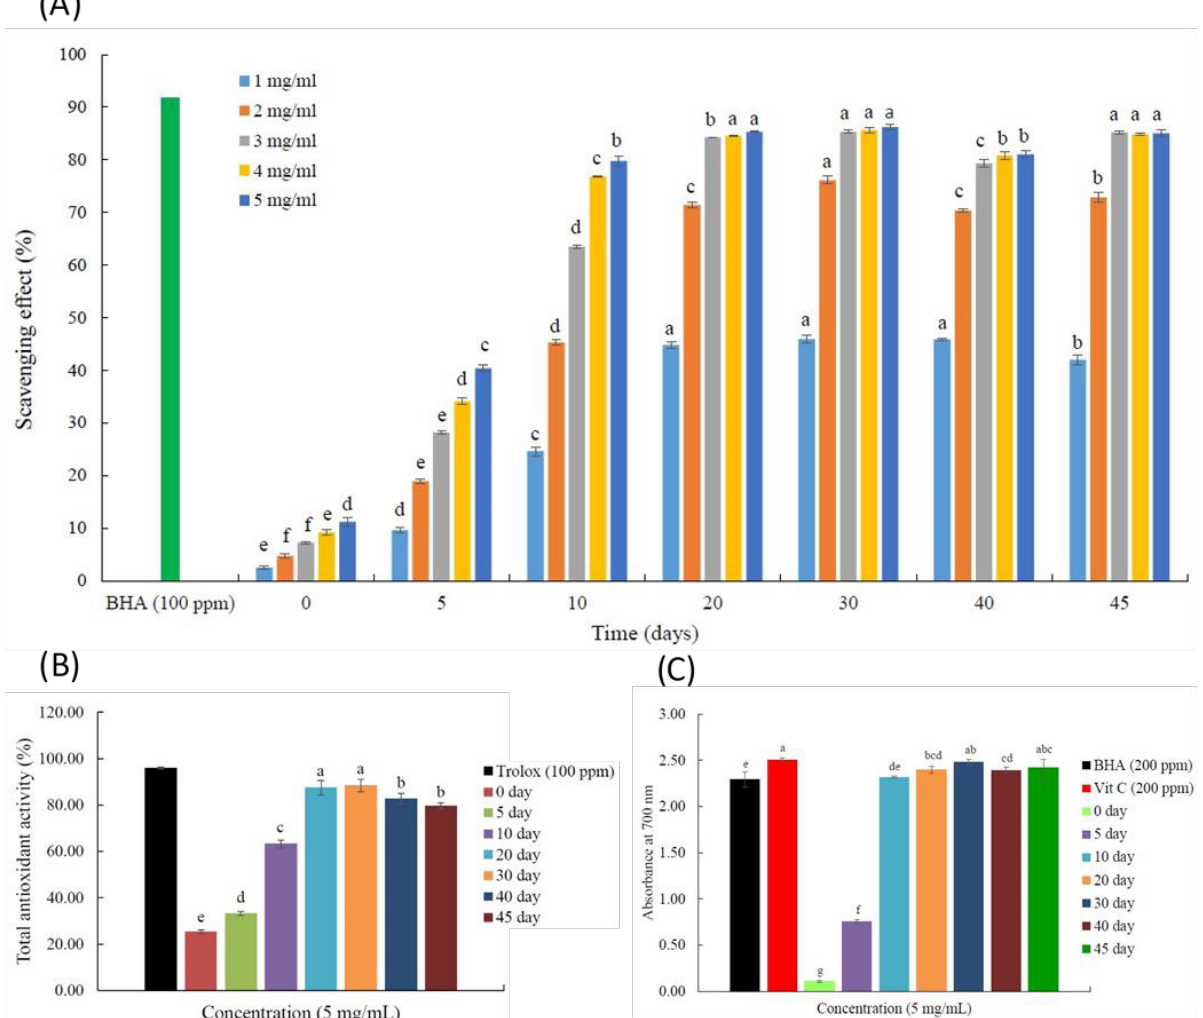
Figure 2. ( A ) DPPH radical scavenging effect, ( B ) total antioxidant activity, and ( C ) reducing power of hot-water extracts obtained from fresh garlic and black garlic with different aging durations. ( B ) Values are shown as the mean ± S.D. ( n = 3). Different superscript letters indicate a significant difference ( p < 0.05).